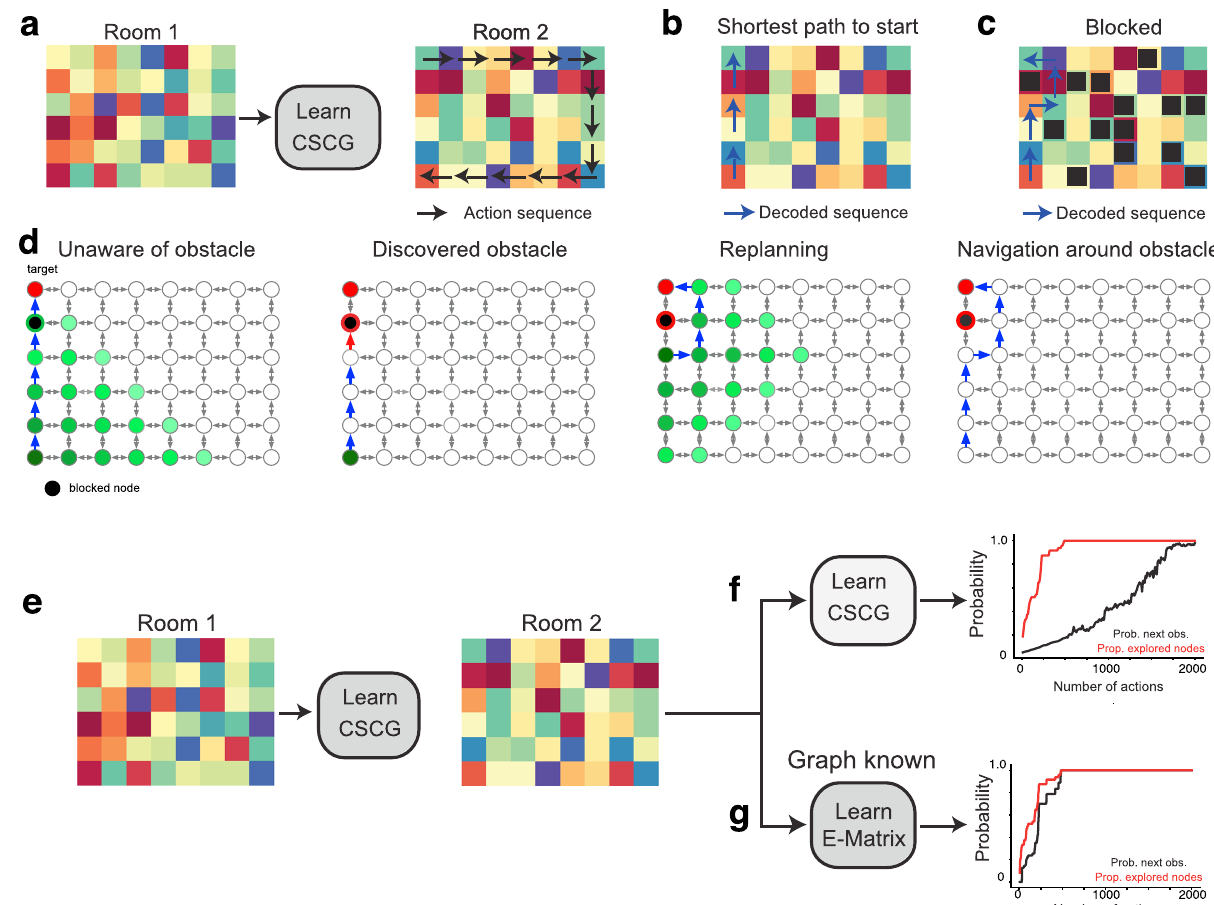
Fig. 3 Learned transition graphs form a reusable schema. A CSCG trained on one room ( a ) and partial observations in a second, previously unseen room with identical hidden layout, utilizes the learned structure of the room to rapidly fi nd both the shortest path to the origin ( b ) and navigate around obstacles ( c ). d Visualization of message propagation during planning and replanning. Messages propagate outward from the starting clone, and clones that receive the message are indicated in green color. Lighter shades indicate messages that are later in time. The fi rst plan is unaware of the obstacle, and the agent discovers the obstacle only when the action sequence is executed and a planned action fails (red arrow). This initiates a replanning from the new location, and the new plan routes around the obstacle. e – g The transition matrix (graph) learned in one room can be used as a reusable structure to quickly learn a new room with the same layout but different observations. Learning is faster when CSCG transition graph is used as a schema to learn the new room ( g ) compared to learning from scratch ( f